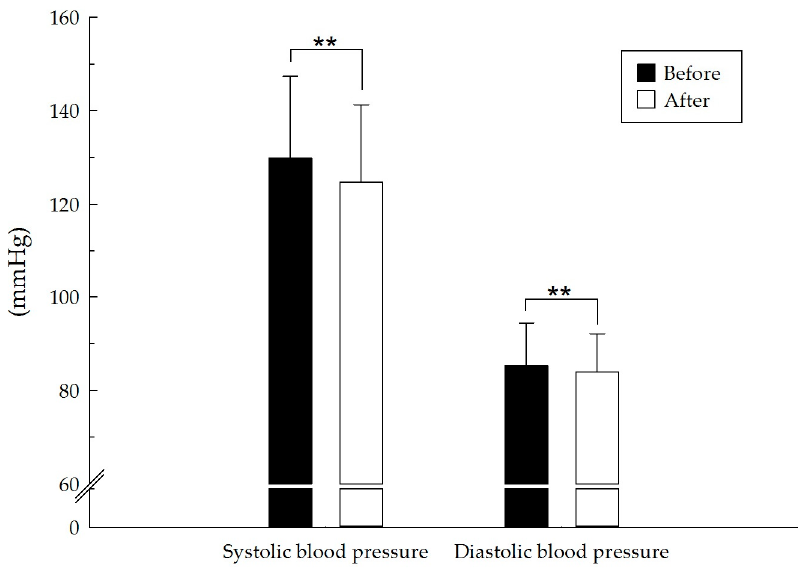
Figure 3. Effect of the short forest bathing program on systolic and diastolic blood pressure. N = 128, mean ± standard error. ** p < 0.01, paired-sample t test.